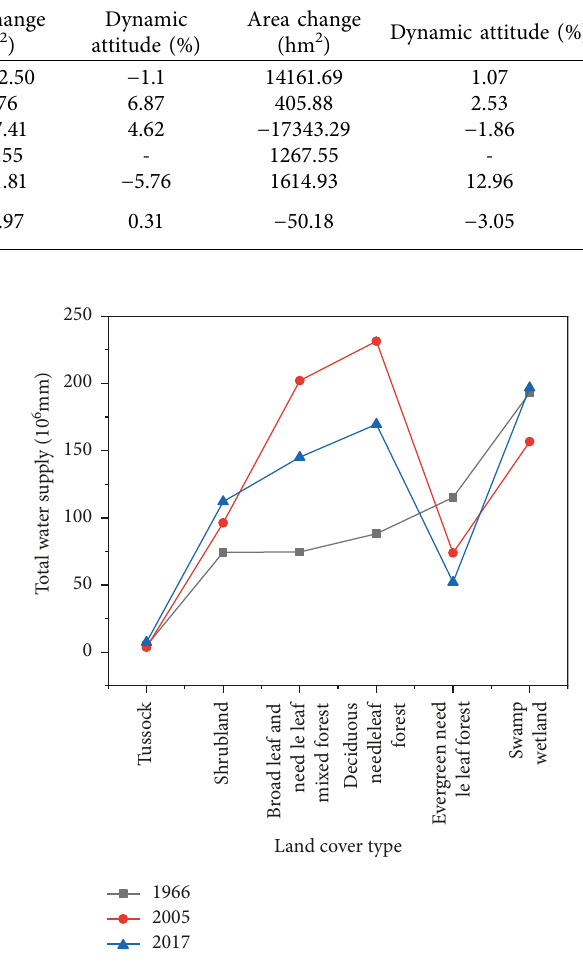
Figure 3: Water supply of each land cover type.